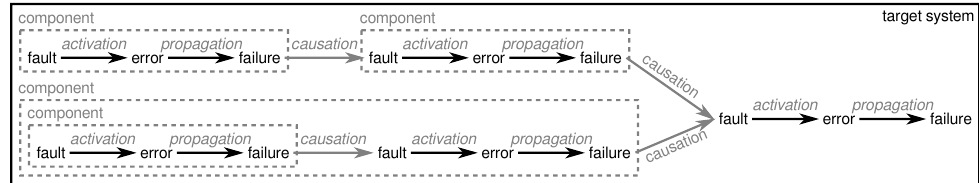
Figure 2. The fundamental chain of dependability & error propagation (after Figures 10 and 11 in [5]).